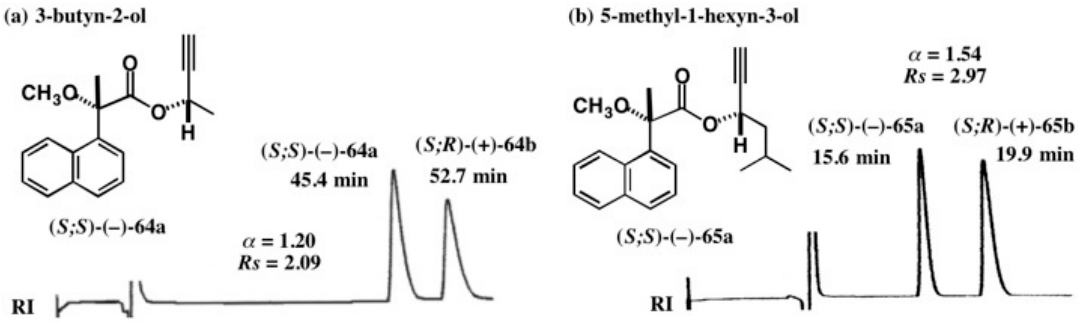
Figure 43. HPLC separation of diastereomeric M α NP esters of acetylene alcohols: ( a ) 3-butyn-2-ol, hexane/EtOAc 20:1, reprinted with permission from [60]; ( b ) 5-methyl-1-hexyn-3-ol, hexane/EtOAc 10:1, reprinted from [61].